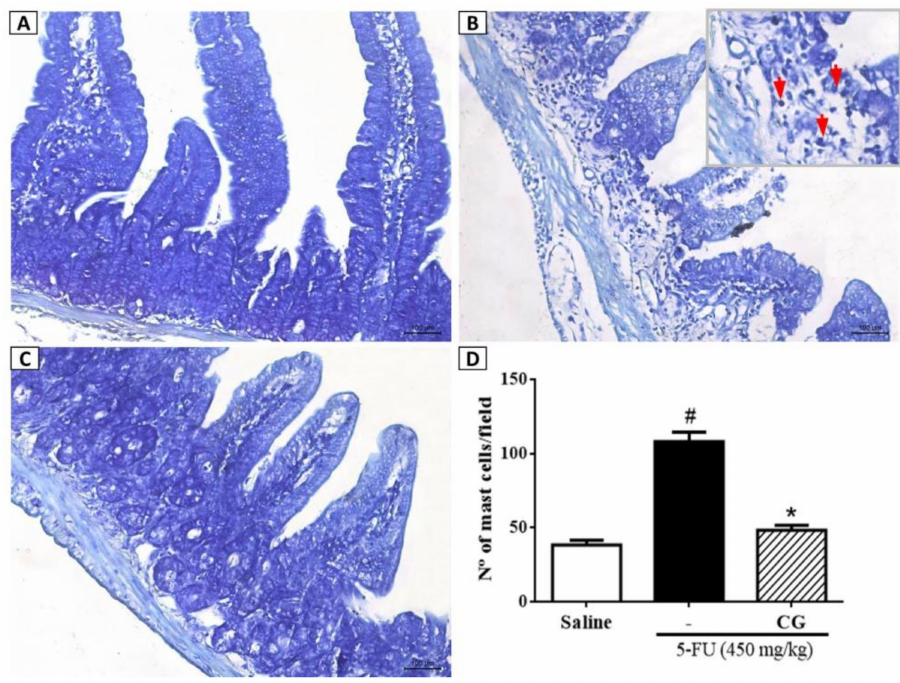
Figure 4. Mast cell counts in the duodenum samples. In ( B ) demonstrates that 5-FU promoted increased mast cell counts (red arrows) when compared to saline group ( A ). CG 90 ( C ) reversed the 5-FU-induced mastocytosis. All the panels were obtained at × 400 magnification. ( D ) Values were presented as mean ± SEM of the number of mast cells per field. For the statistical analysis, tone-way ANOVA followed by Tukey’s test was used, where # p < 0.05 vs. saline group and * p < 0.05 vs. group 5-FU.